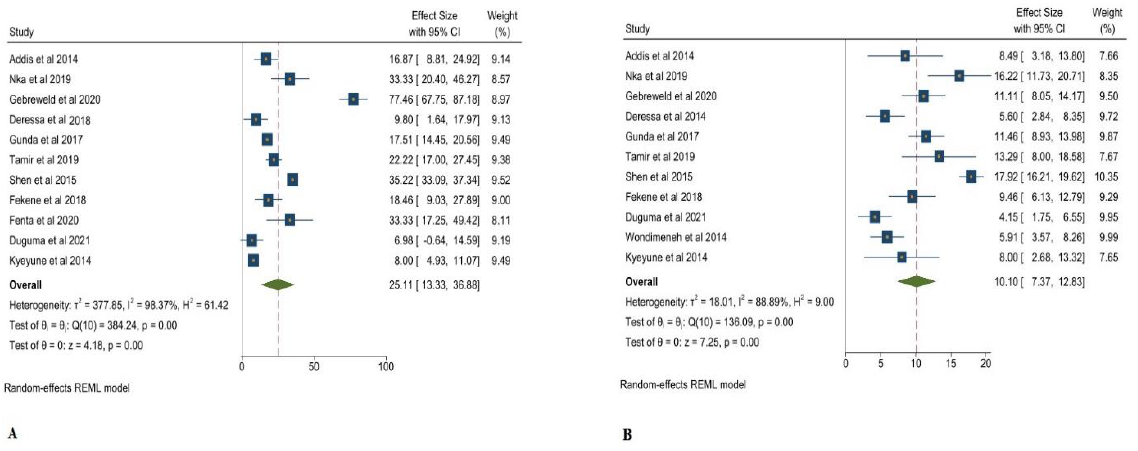
Figure 4. A Pooled prevalence of thrombocytopenia in CD + T < 200 cells/μL ( A ), CD + T > 200 cells/μL ( B ) [1,18 –